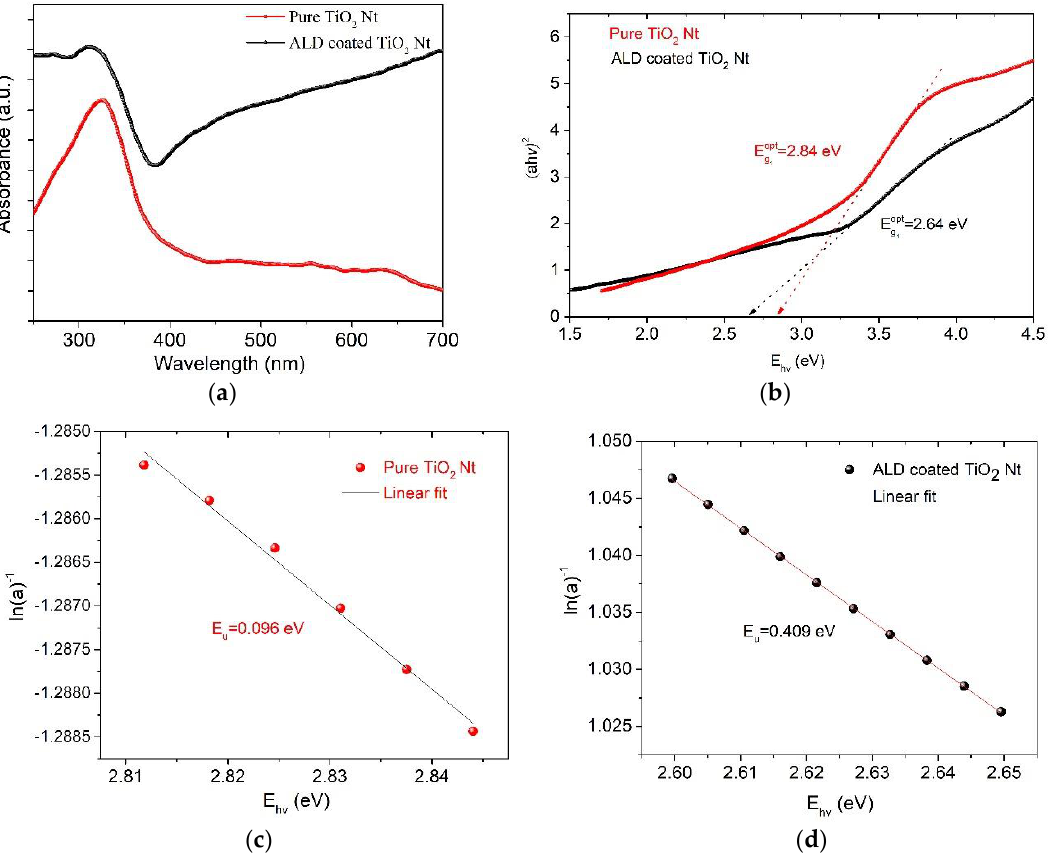
Figure 7. Optical properties of pure and ALD-coated TiO 2 Nt. ( a ) UV-Vis spectra, ( b ) Tauc plots for indirect transition and ( c ) determination of Urbach energy for pure and ( d ) ALD-coated TiO 2 Nt.